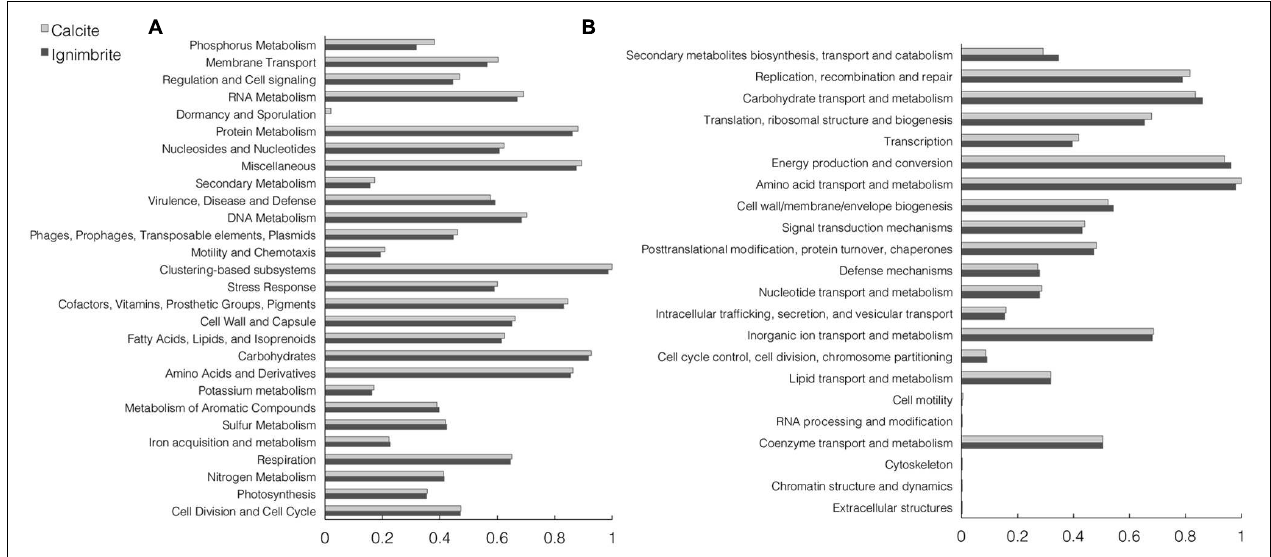
FIGURE 4 | Normalized abundance of functional categories for the calcite and ignimbrite community metagenome sequence reads for (A) SEED subsystems and (B) COG generated with MG-RAST.